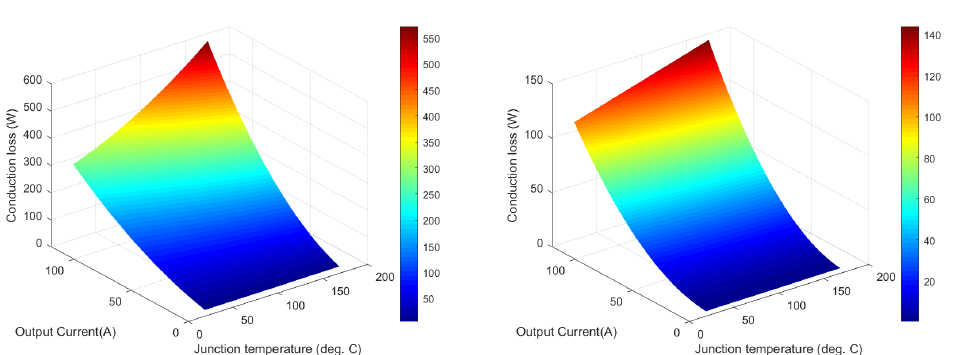
Figure 11. Conduction losses in ( left ) diode and ( right )